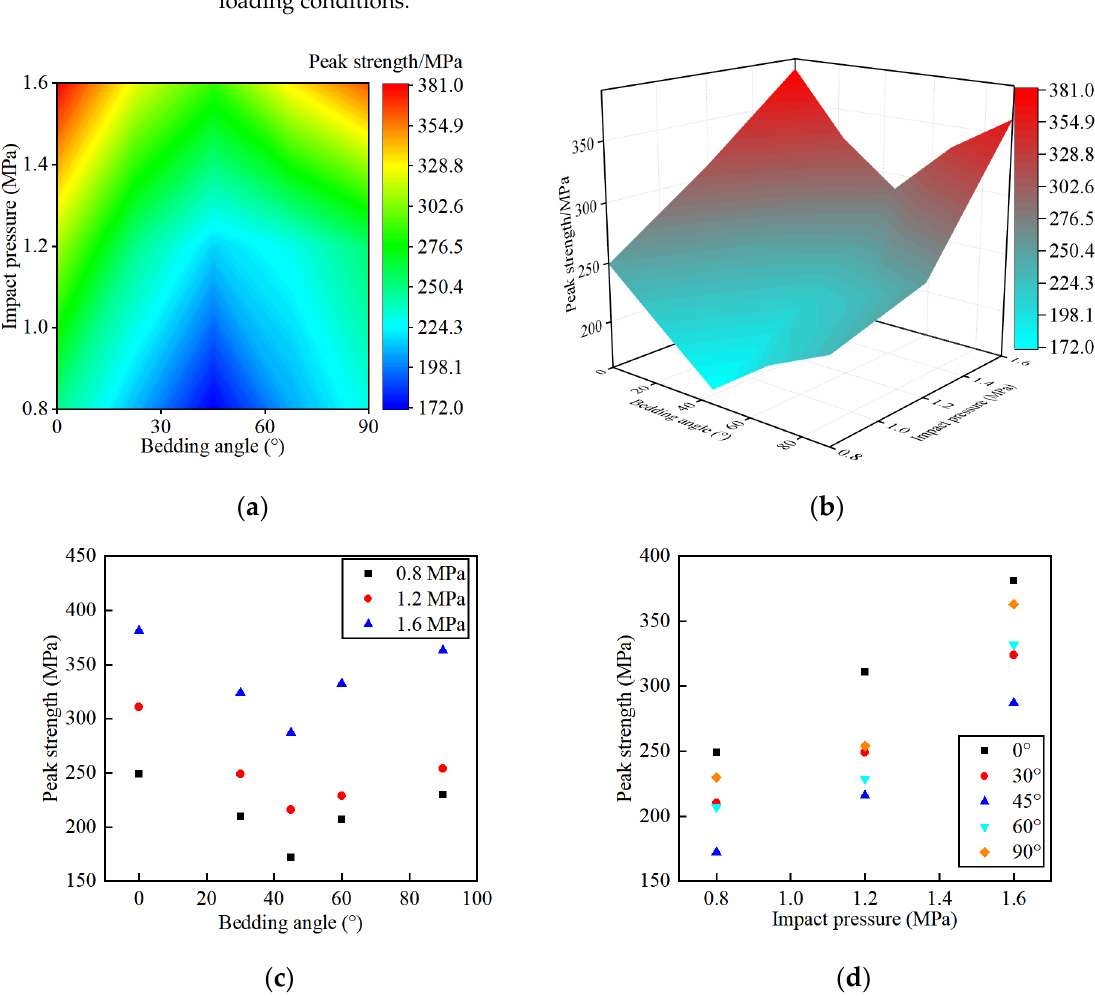
Figure 6. Peak strength of the sandstone samples under different loading conditions ( a ) Two-dimensional cloud map of peak strength. ( b ) Three-dimensional map of peak strength. ( c ) Different bedding angles. ( d ) Different impact pressure.